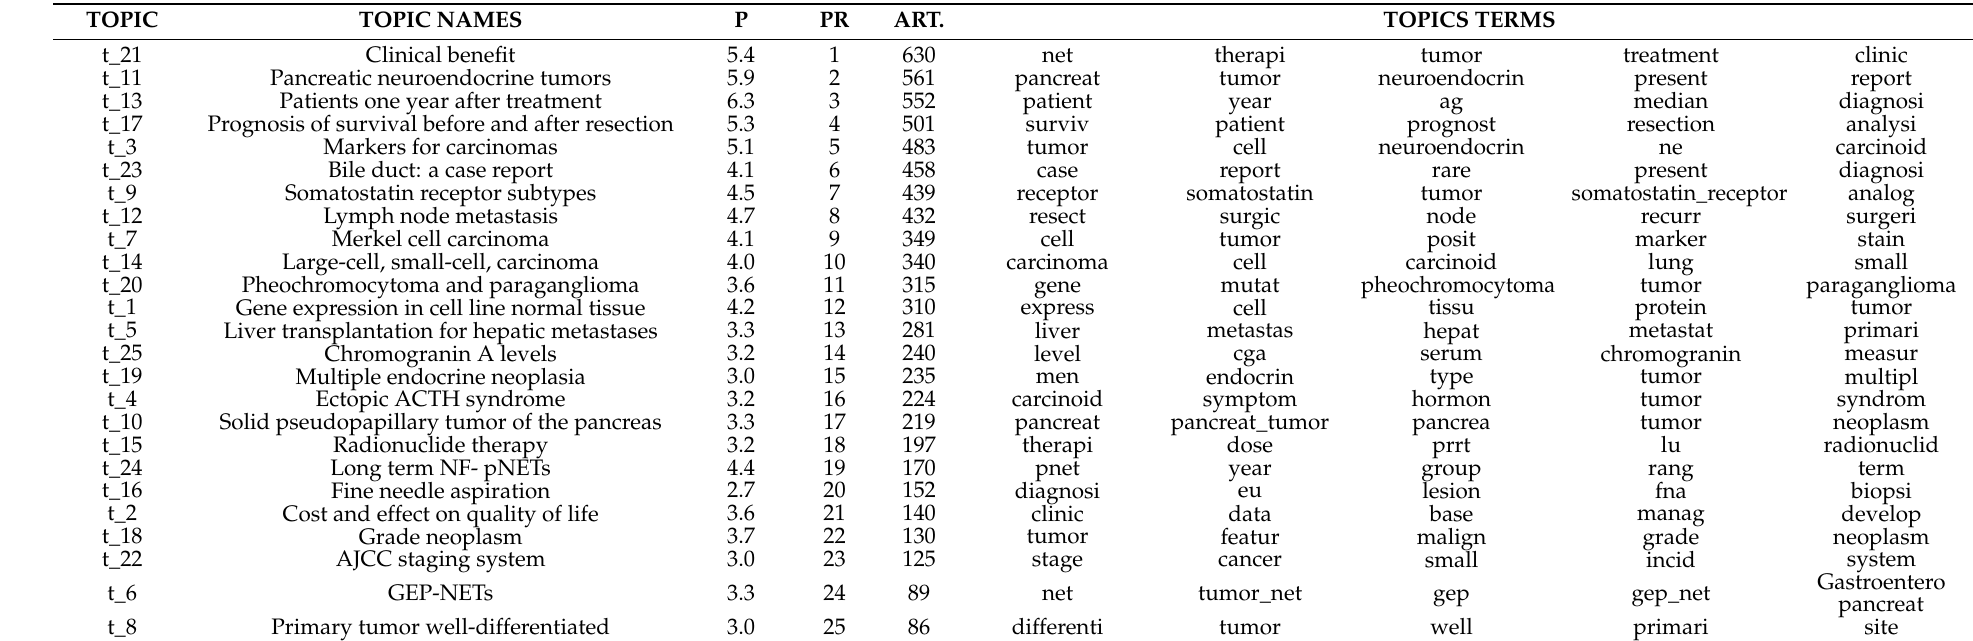
Table 2. Frequent topics, where: P = Prevalence; PR = Prevalence Ranking; ART. = Article